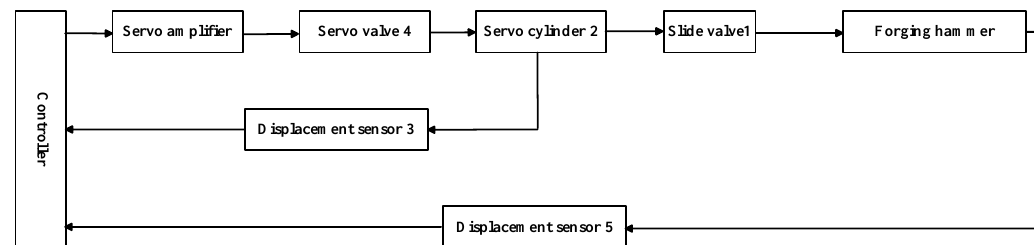
Figure 4. Control diagram of the electro-hydraulic free forging hammer.